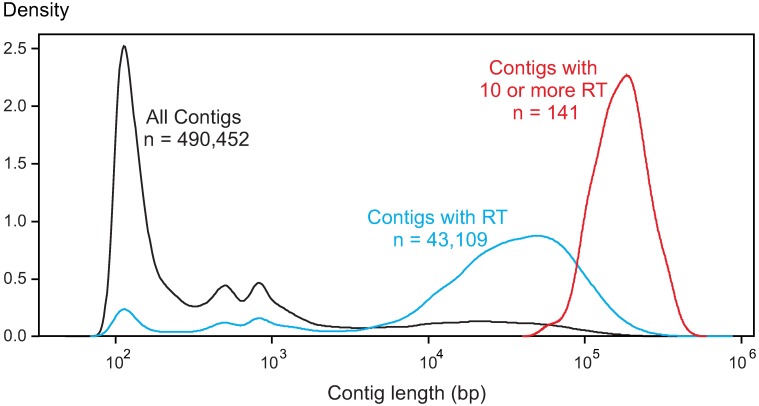
Contig length (bp) density distribution.Figure shows the distributions of contig lengths; blue and red color lines indicate contigs with at least one lentil LTR-RT sequence or 10 or more lentil LTR-RT, respectively. The black line indicates the distribution of all lentil contigs, V0.8 genome. n = number of contigs.